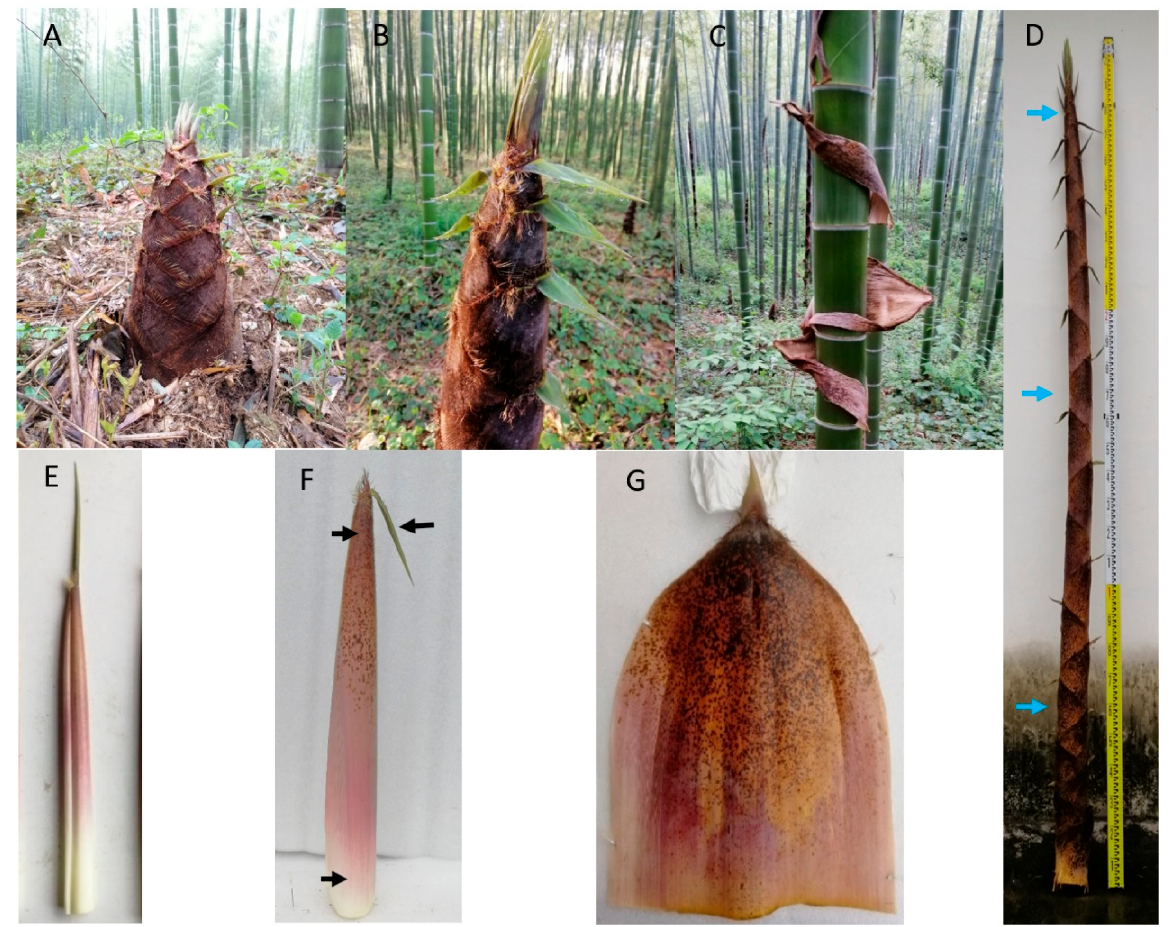
Figure 1. Culm sheaths of moso bamboo shoots at different stages of development and the morpho- logical characteristics of the bamboo sheath. ( A ) Culm sheaths of early bamboo shoots. ( B ) Culm sheaths of a rapidly growing bamboo shoot. ( C ) Culm sheaths in the process of shedding. ( D ) Culm sheaths of 3-m-long bamboo shoots. ( E ) Culm sheaths in the upper parts of 3-m-long bamboo shoots. ( F ) Culm sheaths in the middle of 3-m-long bamboo shoots. ( G ) Culm sheaths in the base of 3-m-long bamboo shoots. Blue arrows indicate sampling locations on bamboo shoots, and black arrows indicate sampling locations on culm sheaths. For bamboo shoots, the sampling sites are “Top,” “Middle,” and “Base” (in order from top to bottom). For a single bamboo sheath, the sampling sites are “sheath base,” “sheath upper,” and “sheath blade” (from bottom to top).